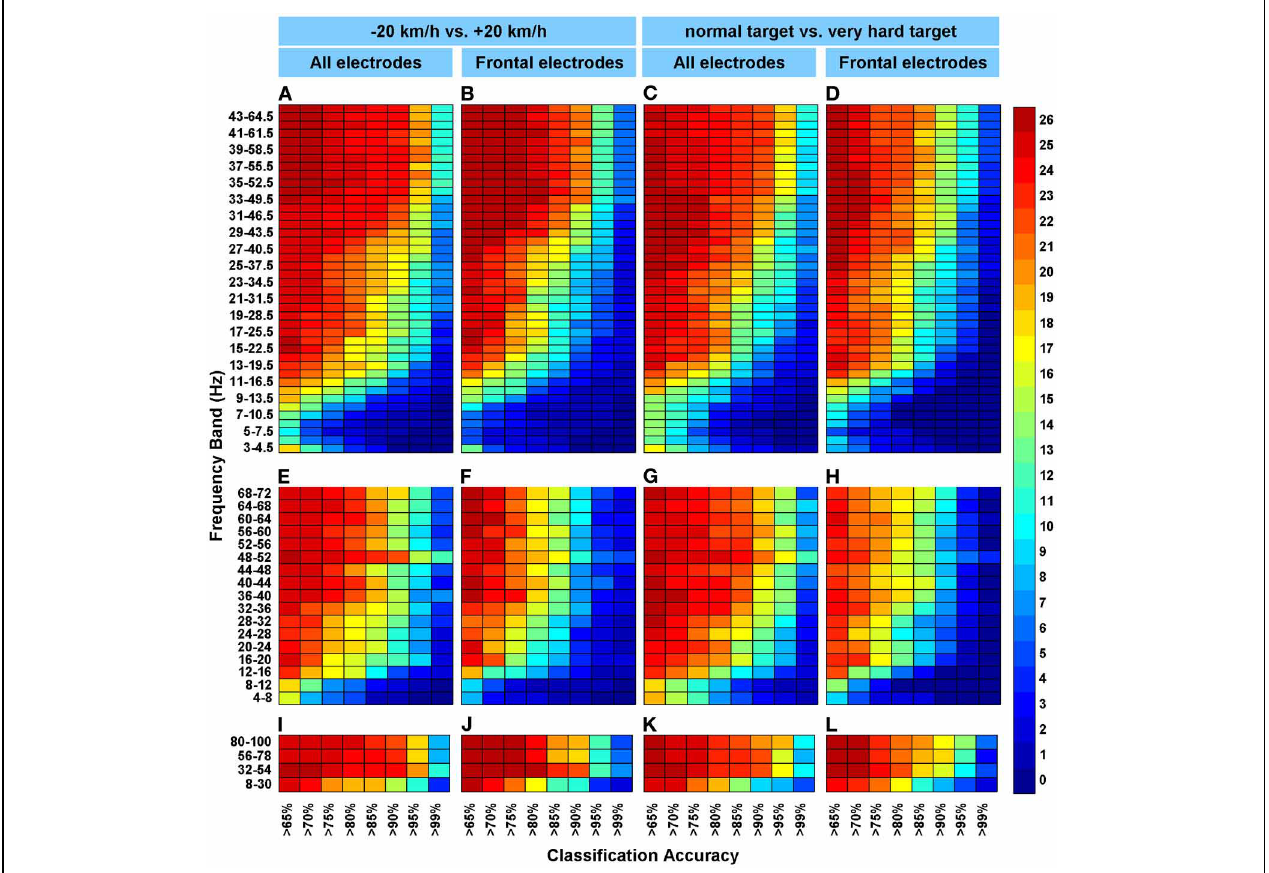
participants’ preferred speed as determined during the initial ride (at normal target level). “Normal target vs. hard target” indicate performance target difficulty (at relative speed = 0km/h). For each row of subfigures, a different frequency search strategy was used. (A–D) For the top row of subfigures, the frequency bandwidth is 1.5 times the begin frequency (step size 1Hz), starting at 3–4.5Hz and ending at 44–66Hz. (E–H) For the middle row of subfigures, 4Hz bands were used and a step size of 4. (I–L) For the bottom row, a broad band frequency (22Hz) search was